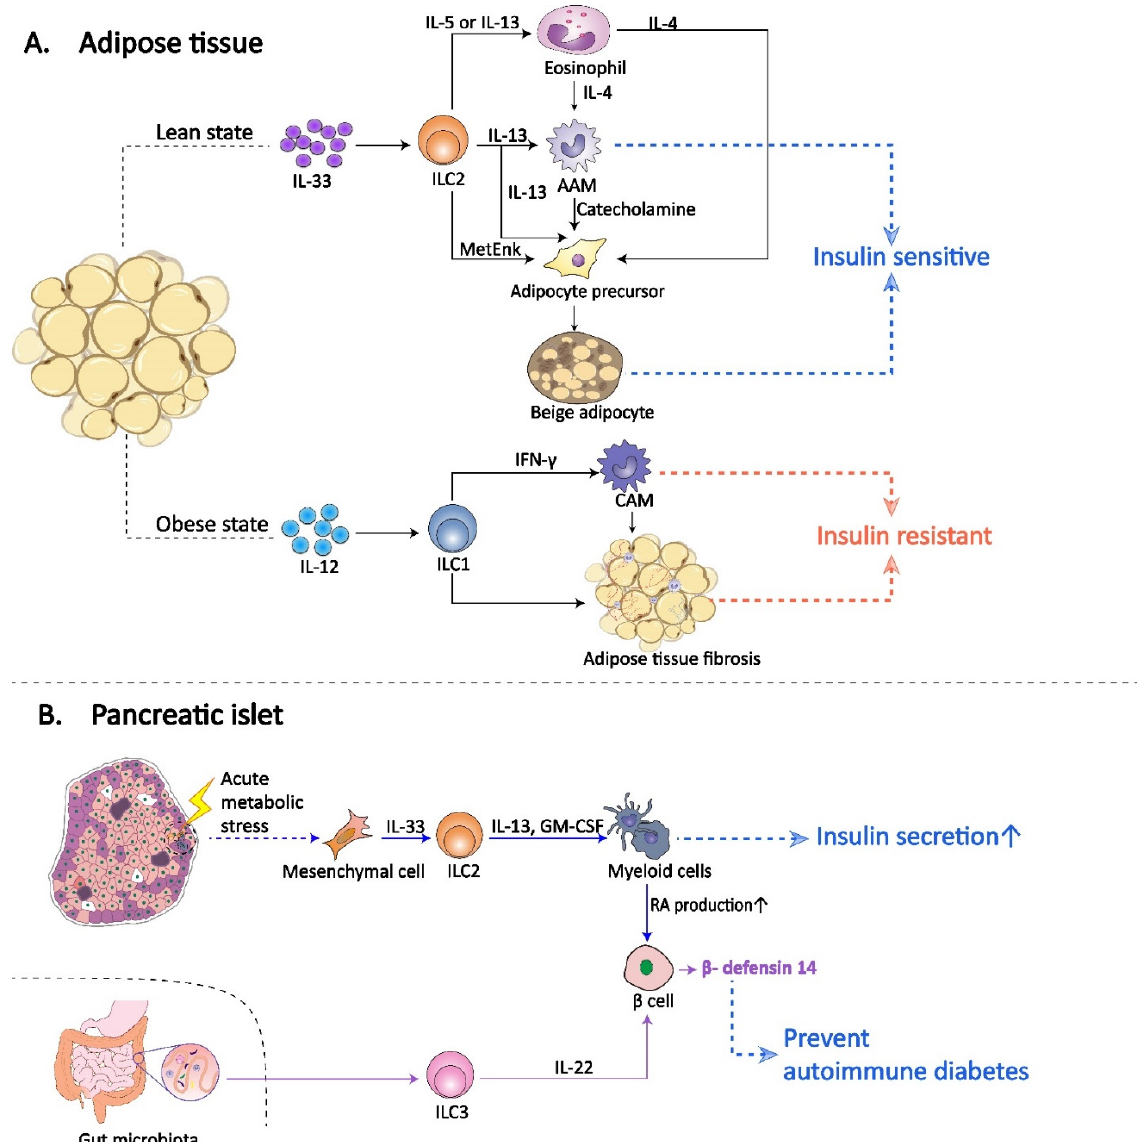
Figure 2. Role of ILCs in diabetes mellitus. A | ILCs in adipose tissue. In the lean state, IL-33 induces adipose-resident ILC2s to produce the cytokines IL-5 or IL-13, which support the recruitment and accumulation of eosinophils in AT. Eosinophils produce IL-4 to sustain and recruit AAMs. ILC2s produce ample IL-13 and may also directly contribute to AAM recruitment and maintenance. AAM byproducts, such as IL-10, contribute to adipocyte insulin sensitivity and protect against DM. In addition, IL-4, IL-13 and methionine-enkephalin peptides (MetEnk) and catecholamines, produced by eosinophils, ILC2s and AAMs, respectively, promote the proliferation and differentiation of adipocyte precursors into beige adipocytes. Beige fat biogenesis also promotes insulin sensitivity and prevents DM. In the obese state, while IL-12 promotes the selective accumulation of adipose-resident ILC1s. ILC1s drive CAM polarization by IFN- γ production and promote AT fibrosis, contributing to obesity-associated insulin resistance and DM. B | ILCs in pancreatic islets. In diabetic or obese states, the islets are also in an inflammatory background. IL-33 is produced by mesenchymal cells as a stress signal in islets. As the main IL-33-responsive cells in islets, islet-resident ILC2s stimulate the capacity of myeloid cells to produce RA, which in turn enhances insulin secretion in islet β cells and protects against DM. In the gut, the microbiota controls IL-22 expression by ILC3s within pancreatic islets through different pathways. ILC3-derived IL-22 induces islet β cells to produce β -defensin, preventing autoimmune